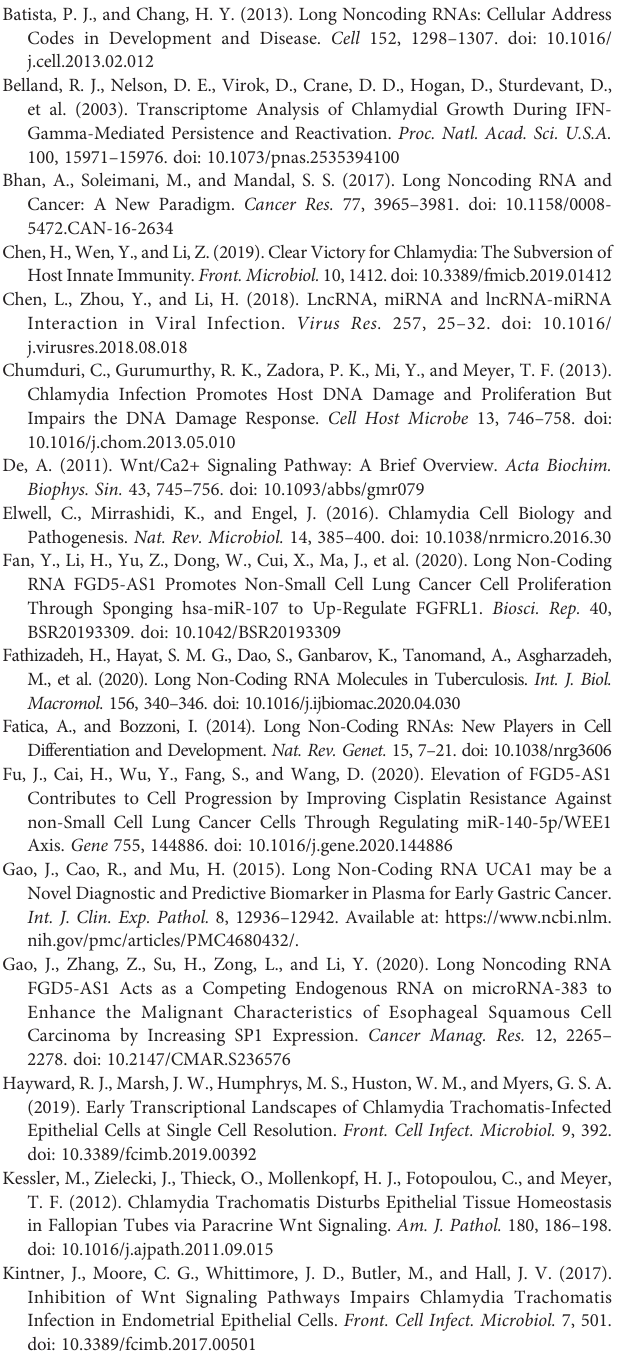
indicates the related function between genes. (B) Differentially expressed mRNAs at three time points are used to construct a PPI network by Metascape software, and visualized by Cytoscape 3.7.1. (C) The top 50 hub mRNAs from PPI were included using Edgecount. The closer to red, the more central the gene is. The size of the circle represents the signi fi cance of a gene. (D) Sub-networks screened from PPI network by MCODE in Cytoscape. A kind of colors represents a cluster participate in the same biological